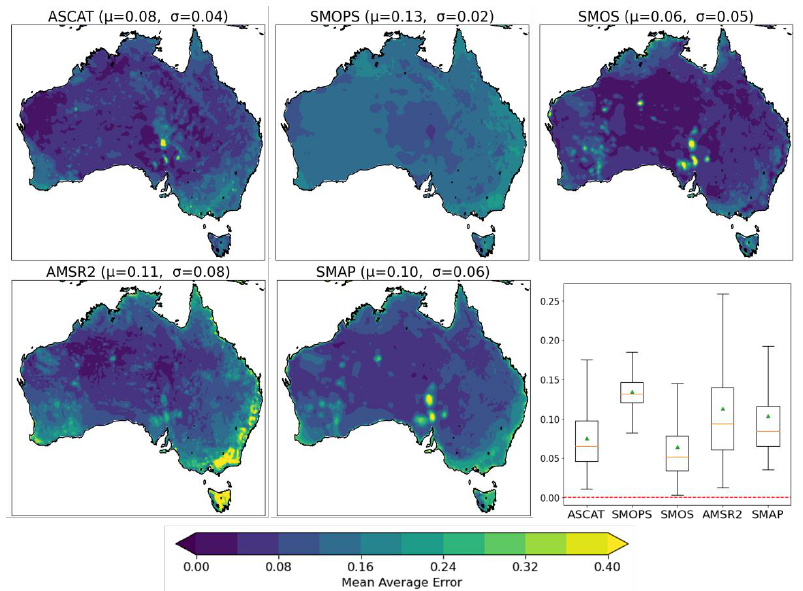
Figure 7. Temporal MAE results depicted spatially for ASCAT, SMOPS, SMOS, AMSR-2, and SMAP. An accompanying box-whisker plot depicts the spatio-temporal results — whiskers extend out to show the interquartile range, the orange line indicates the distribution median, and the green triangle indicates the distribution mean, red dashed line indicates perfect value.